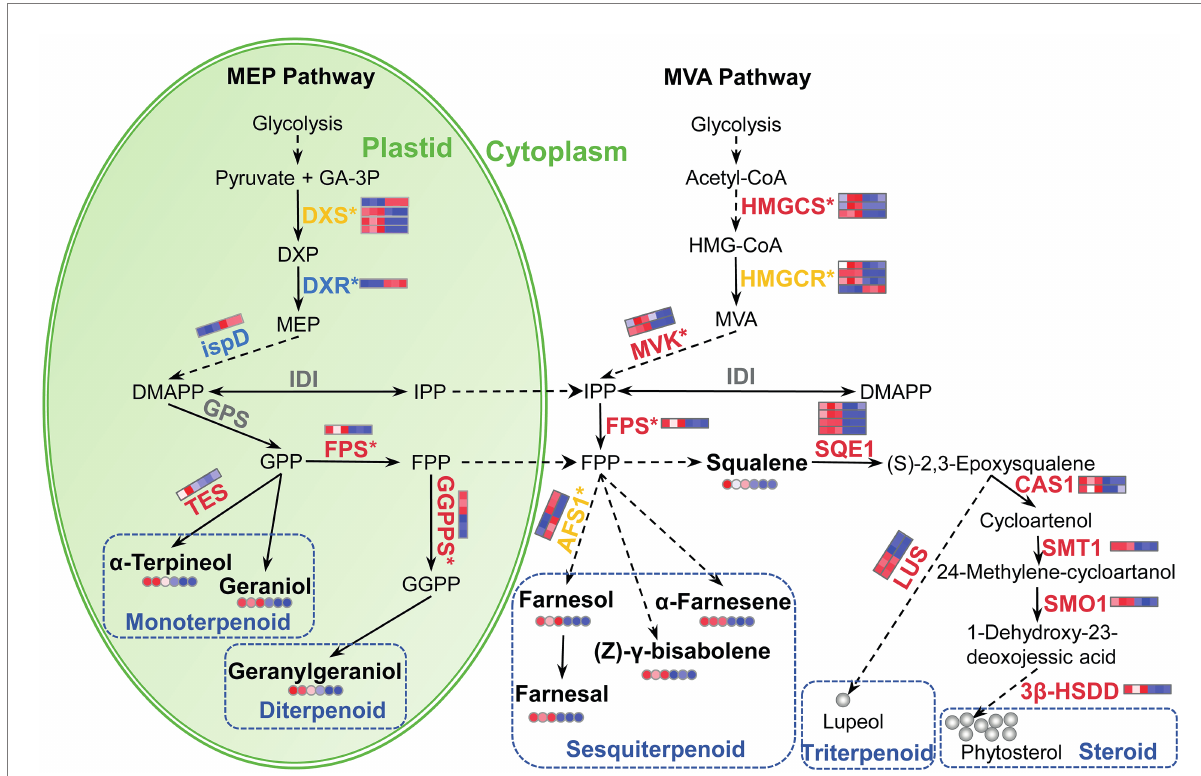
FIGURE 8 Schematic presentation of terpenoid biosynthetic pathway in LJFs of ‘Yujin2’ compared to ‘Fengjin1’. The upregulated, downregulated, mix- regulated, and unchanged genes (bold fonts) and metabolites (small circles) in ‘Yujin2’ are represented in red, blue, yellow, and gray, respectively. The scale bars adjacent to the name of genes or metabolites are picked from the heatmaps for the transcriptome (Figure 4D) and metabolome (Figure 3C). The first three and the latter three squares of a bar represent the normalized abundance values of DEGs or DAVs from ‘Yujin2’ and ‘Fengjin1’, respectively. Red and blue colors reflect high and low expression levels, respectively. The asterisk followed by the gene name indicate that the gene expression was validated by qRT-PCR. The solid line, dashed line, and dotted line indicate a single-step reaction, a multi-step reaction, and the movement of substances, respectively. 3 β -HSDD, plant 3 β -hydroxysteroid-4 α -carboxylate 3-dehydrogenase; Acetyl-CoA, acetoacetyl-CoA; AFS1, alpha-farnesene synthase; CAS1, cycloartenol synthase; DMAPP, dimethylallyl pyrophosphate; DXP, 1-deoxy-d-xylulose 5-phosphate; DXR, DXP reductoisomerase; DXS, DXP synthase; FPP, farnesyl diphosphate; FPS, farnesyl diphosphate synthase; GA-3P, D-glyceraldehyde 3-phosphate; GGPP, geranylgeranyl diphosphate (C20); GGPPS, GGPP synthase; GPP, geranyl diphosphate; GPS, geranyl diphosphate synthase; HMG-CoA, 3-hydroxy-3-methylglutaryl-CoA; HMGR, HMG-CoA reductase; HMGS, HMG-CoA synthase; IDI, IPP isomerase; IPP, isopentenyl diphosphate; LUS, lupeol synthase; MEP, methylerythritol phosphate; MVA, mevalonic acid; MVK, mevalonate kinase; SMO1, plant 4,4-dimethylsterol C-4alpha-methyl-monooxygenase; SMT1, sterol 24-C-methyltransferase; SQE1, squalene monooxygenase; TPS, alpha-terpineol